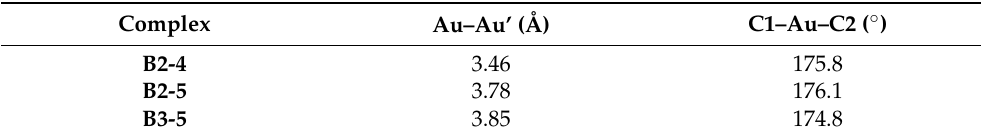
Table 1. Au–Au distances between the neighboring molecules and selected bond angles in B x - y crystals.